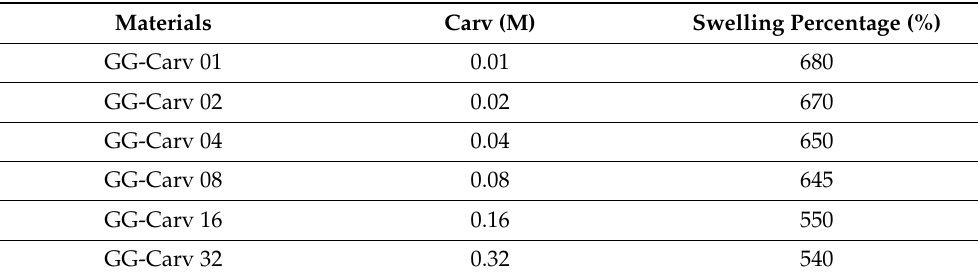
Figure 4. The swelling percentages of GG-Carv 01, GG-Carv 02, GG-Carv 04, GG-Carv 08, GG-Carv 16 and GG-Carv 32. Table 2. The effect of Carv loading on swelling percentage of